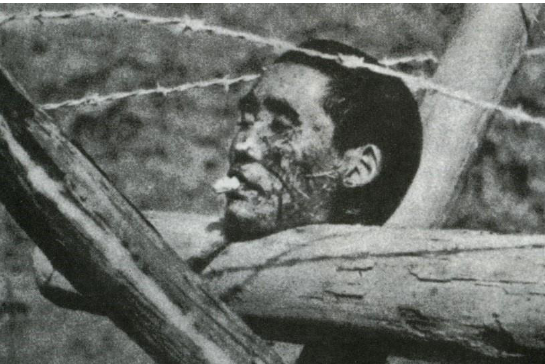
Figure 6. Severed Chinese head. Source: AP